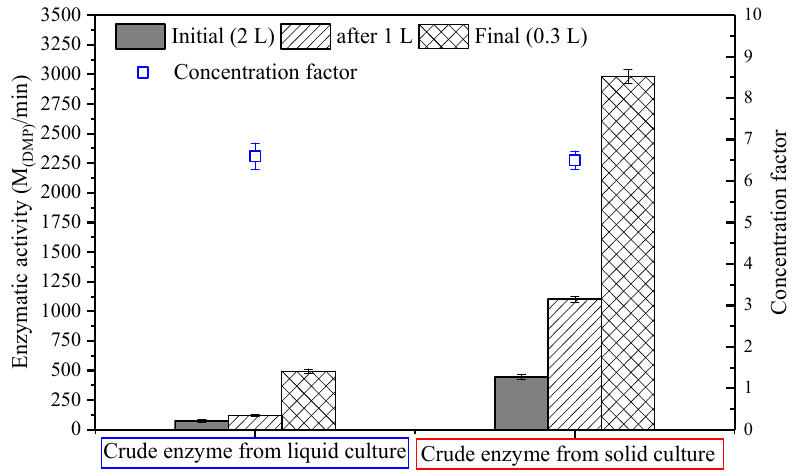
Figure 4. Laccase activity profiles at different solutions. The concentration factor was the ratio of the final over initial laccase activity. The data were the average and standard deviation of three measurements.